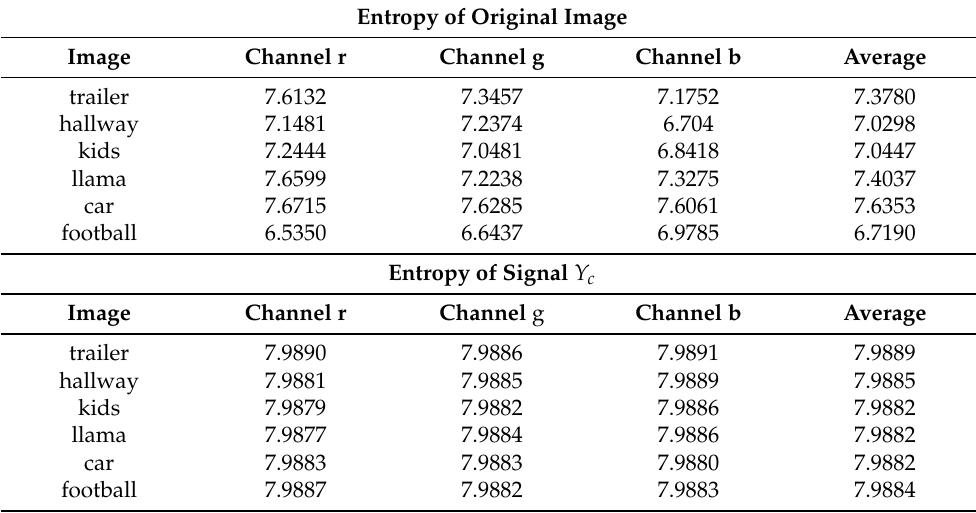
Table 9. Experimental results of image entropy. The compression rate is